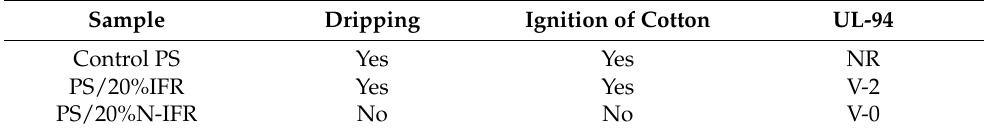
Table 2. The UL-94 results for PS composites.